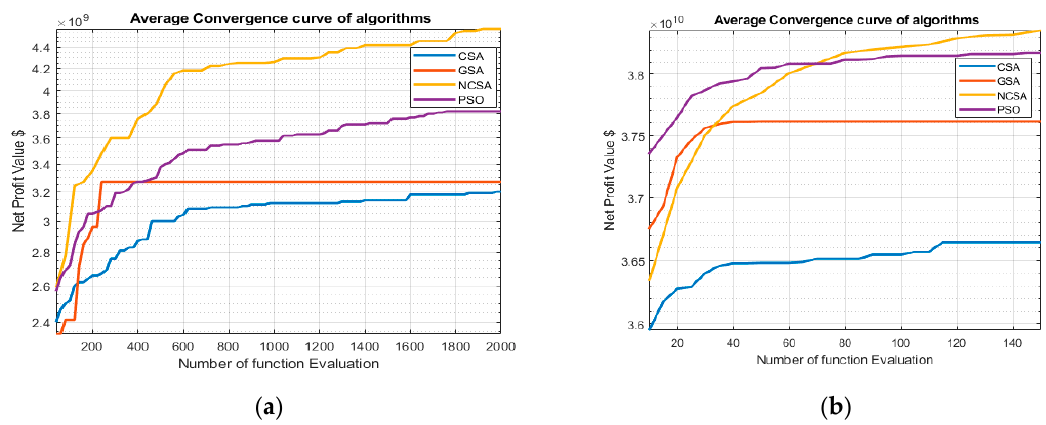
Figure 9. Convergence curve for PSO, CSA, GSA, and NCSA ( a – b ), ( a ) Case study 1 and ( b ) Case study 1.